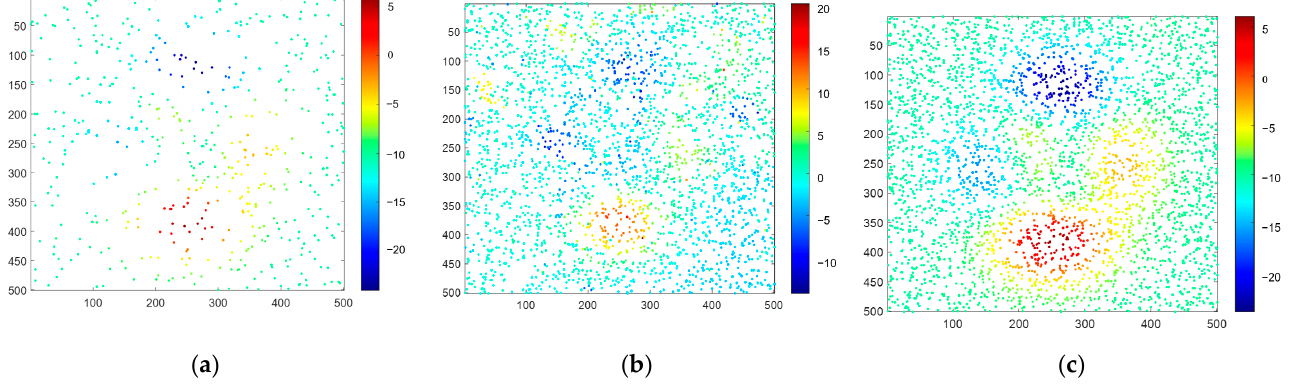
Figure 6. Deformation rates estimated using ( a ) PSI, ( b ) MLE combining PSs and DSs, and ( c ) the proposed method.